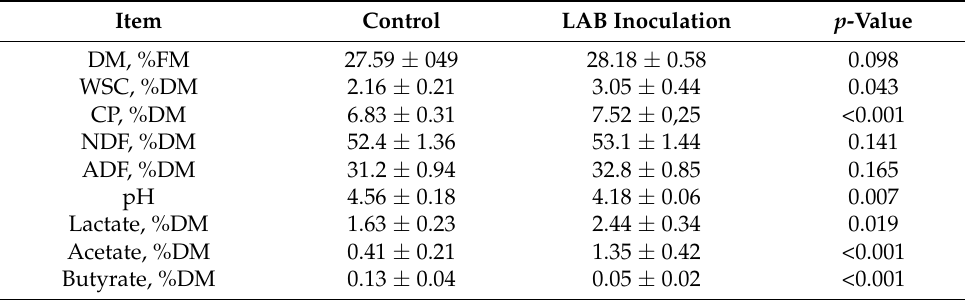
Table 1. Chemical and microbial compositions of silages fed to